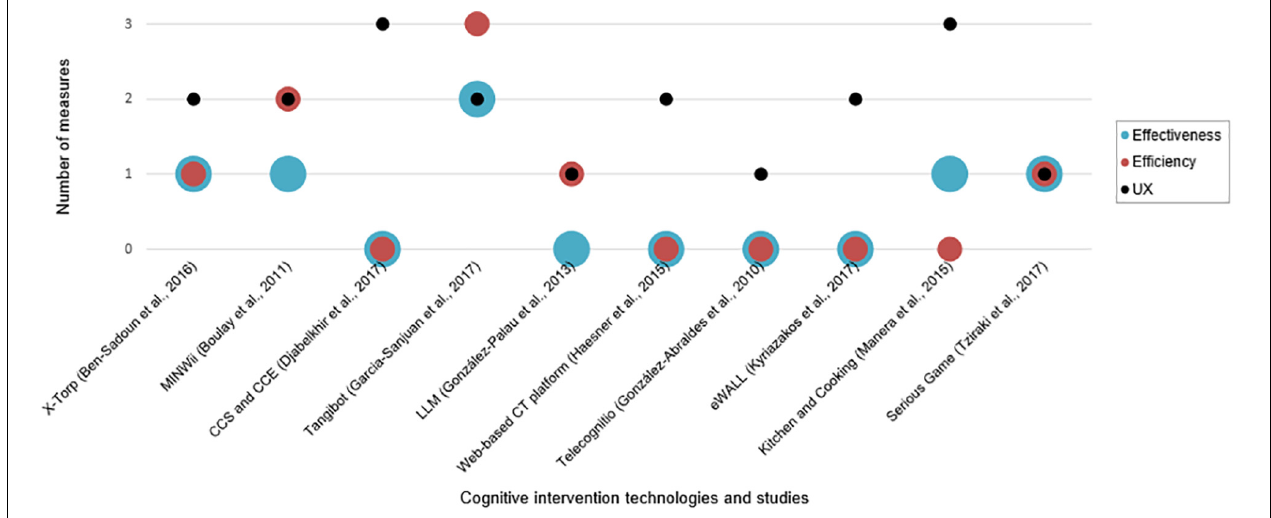
FIGURE 2 | Number of effectiveness, efficiency, and UX measures used in the